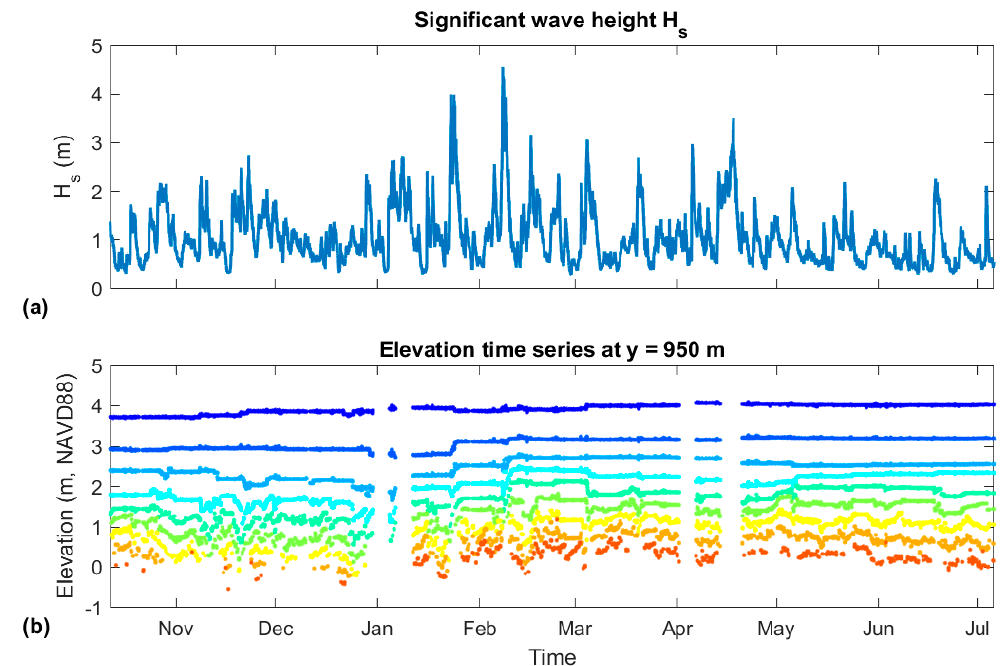
Figure 8. Time series from 12 October 2015 through 5 July 2016 of ( a ) H s (in 8 m water depth) and ( b ) elevation at 9 different cross-shore locations ( x = 55 m to 95 m at 5 m spacing) and a fixed alongshore location ( y = 950 m). In ( b ), blue colors indicate higher locations on the beach face and red colors indicate lower locations on the beach face.